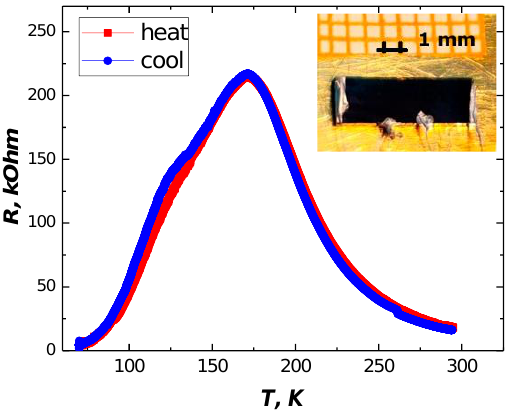
Figure 2. Temperature dependences of the resistance R (T) for the Ba 0.8 Sr 0.2 TiO 3 /LaMnO 3 /Ba 0.8 Sr 0.2 TiO 3 heterostructure. A picture of the sample with applied electrodes is shown in the